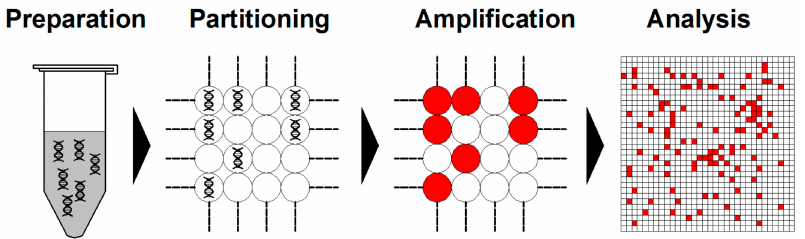
Figure 3. Schemes of typical digital PCR (dPCR) workflow. Generally, dPCR is conducted following the steps of preparation, partitioning, amplification, and